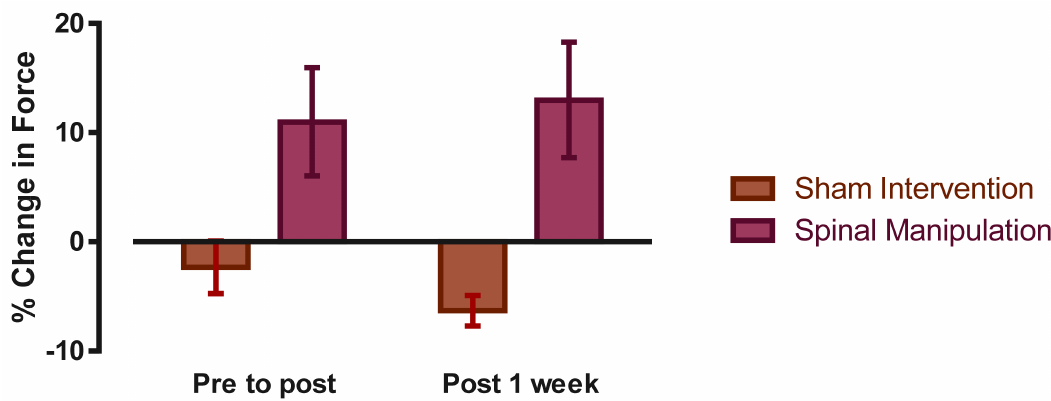
Figure 3. Average percentage change in total bite force values (mean ± SE) for both spinal manipulation and Sham (control)